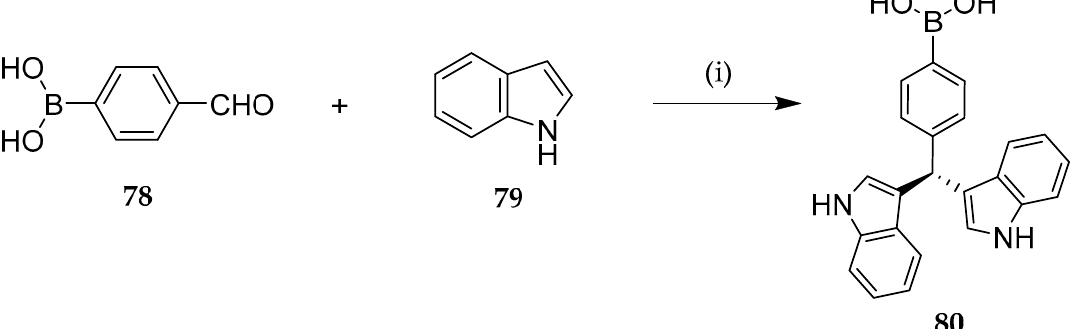
Scheme 17. Synthesis of NorA e ffl ux pump boronic acid inhibitors compounds 76 and 77 . Reaction conditions: ( i ) (1) NaH, anhydrous THF, 0 ◦ C to r.t., 30 min then reflux, 1 h; (2) 5-bromo-2-fluoropyridine,